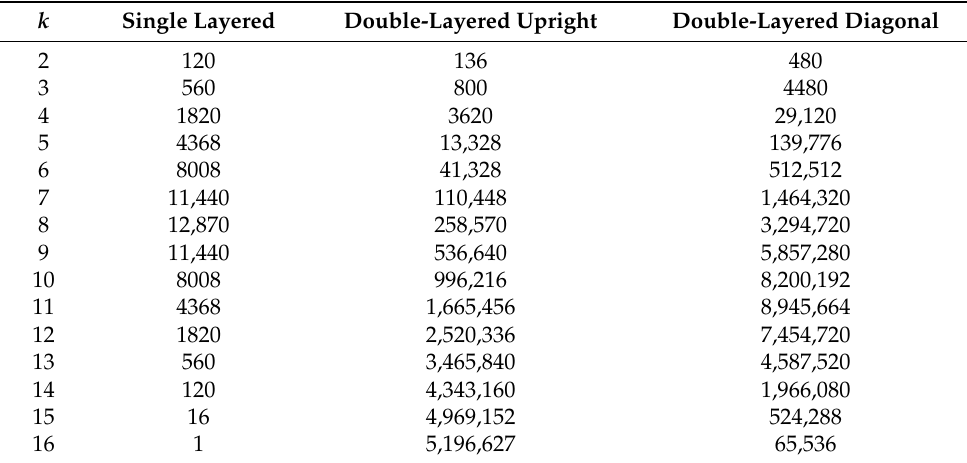
Table 1. Number of combinations per package for n = 16 in standard (single-layered), double-layered upright, and double-layered diagonal machines.